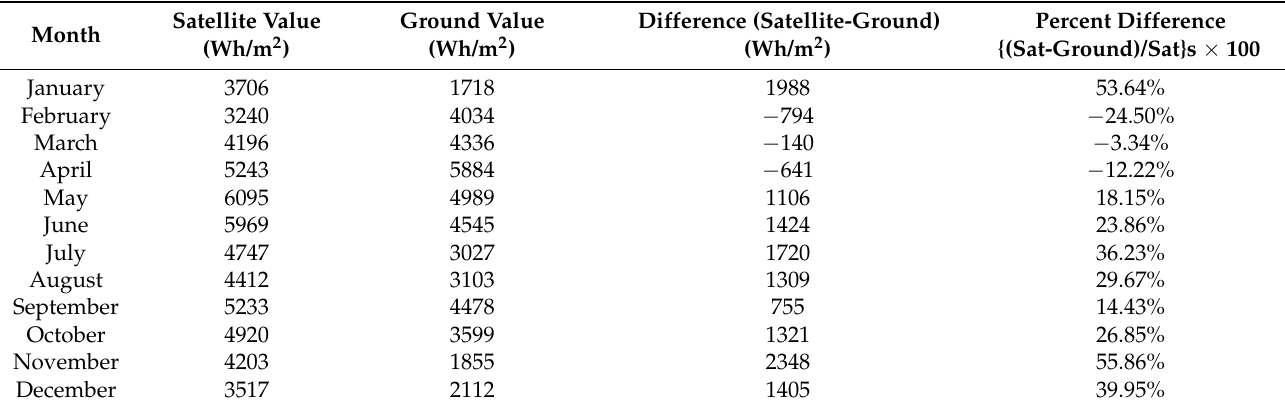
Figure 7. Comparison of ground-based monthly DNI with satellite-based DNI. Table 4. Comparison of ground-based monthly DNI with satellite-based